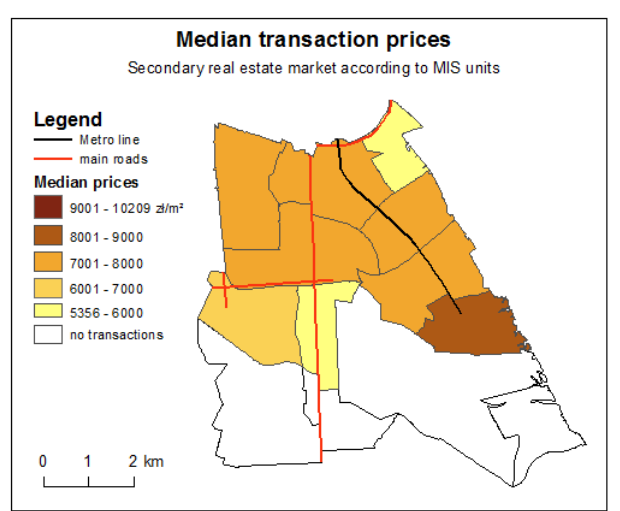
Fig. 5. Average prices of residential premises on the secondary real estate market in Ursynów, according to MIS units